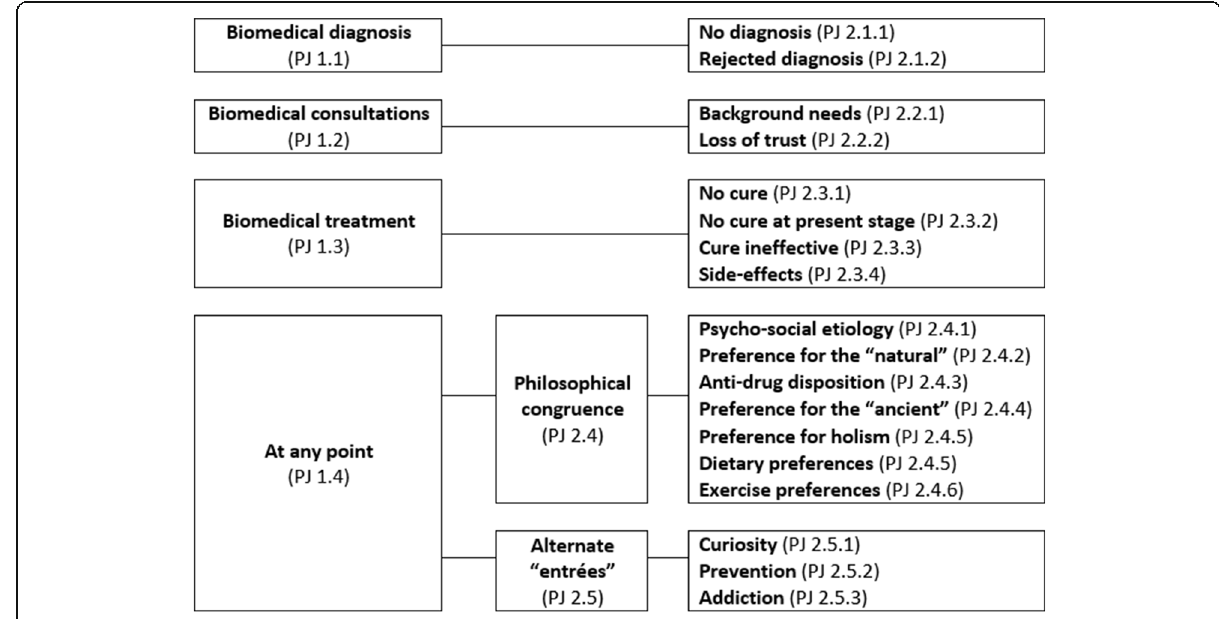
Fig. 1 Integrated code tree of PJ 1 and PJ 2